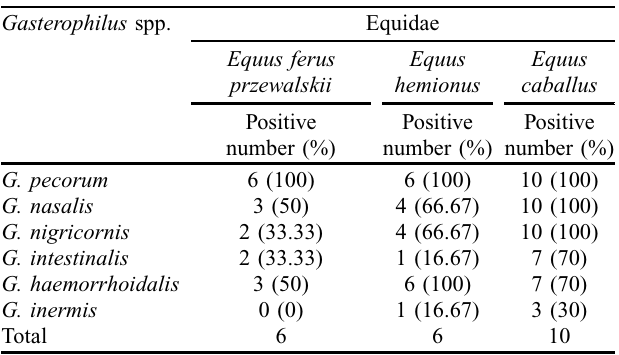
Table 2. Intensity of Gasterophilus spp. larvae in three equids in Kalamaili Nature Reserve, China. Gasterophilus spp.